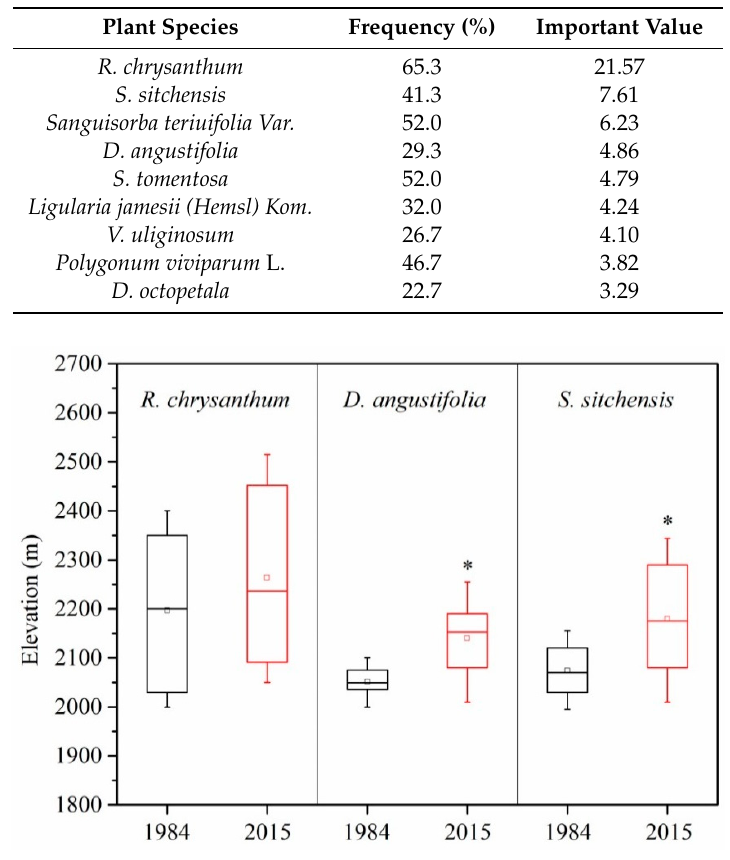
Figure 4. The differences of elevation ranges for R. chrysanthum , D. angustifolia , and S. sitchensis between historic and current vegetation survey. * represents a difference that is significant at the 0.05 level.